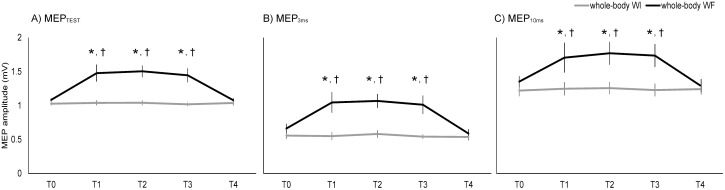
Changes in MEP amplitude for each intervention.MEPTEST, MEP3 ms, and MEP10 ms were induced by the test stimulus (TS) alone, after conditioning stimulus (CS) by TMS at ISIs at 3 and 10 ms, respectively. Asterisks (*) indicate significant differences (p<0.05) compared with T0. Daggers (†) indicate significant differences (p<0.05) compared with T4.